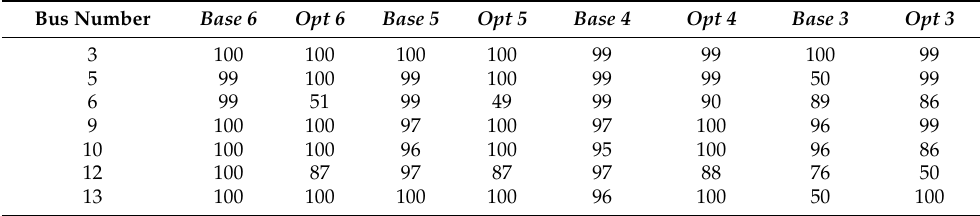
Table 4. Harmonic source locator accuracies for harmonic metering scenarios of Table 2.